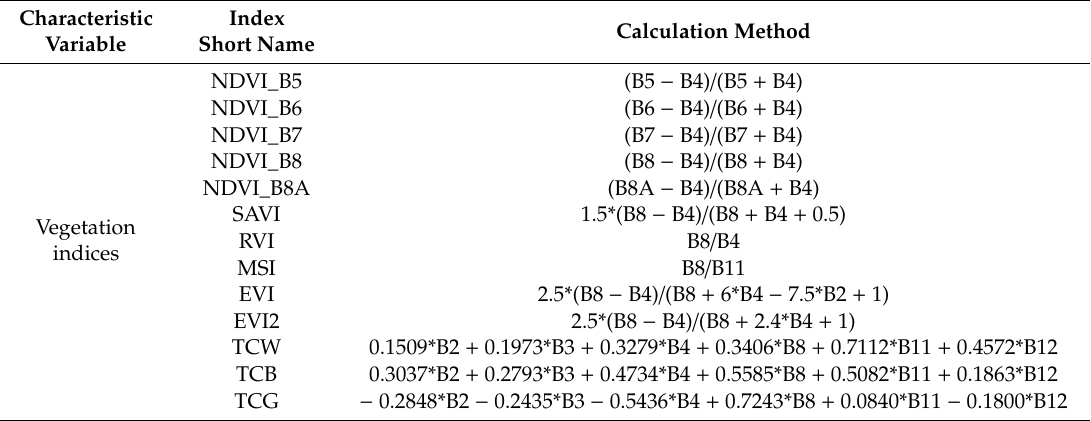
Table 3. Vegetation indices calculated from Sentinel-2